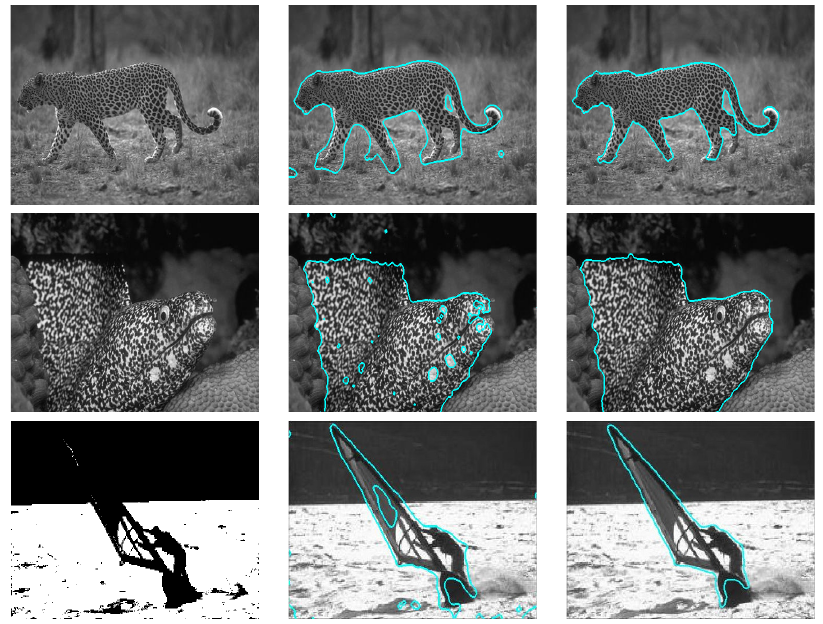
Figure 4. Left column: Original images coming from the Berkeley database which presents textured features. Central column: our segmentation results based on the descriptor coming from [46]. Right column: our segmentation results based on our